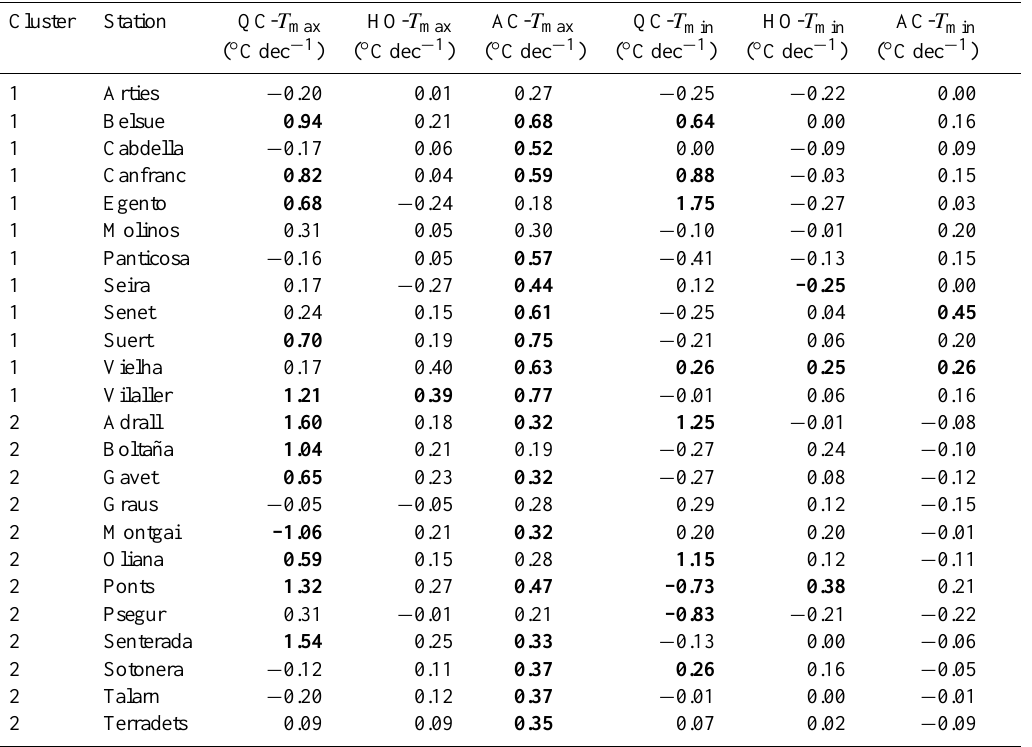
Table 1. Slope trends in ◦ Cdecade − 1 for the period 1961–1990 for each station with more than 80% of monthly data in this period. Significant trends (evaluated using the Student’s t test with a significance level of p < 0.05) are shown in